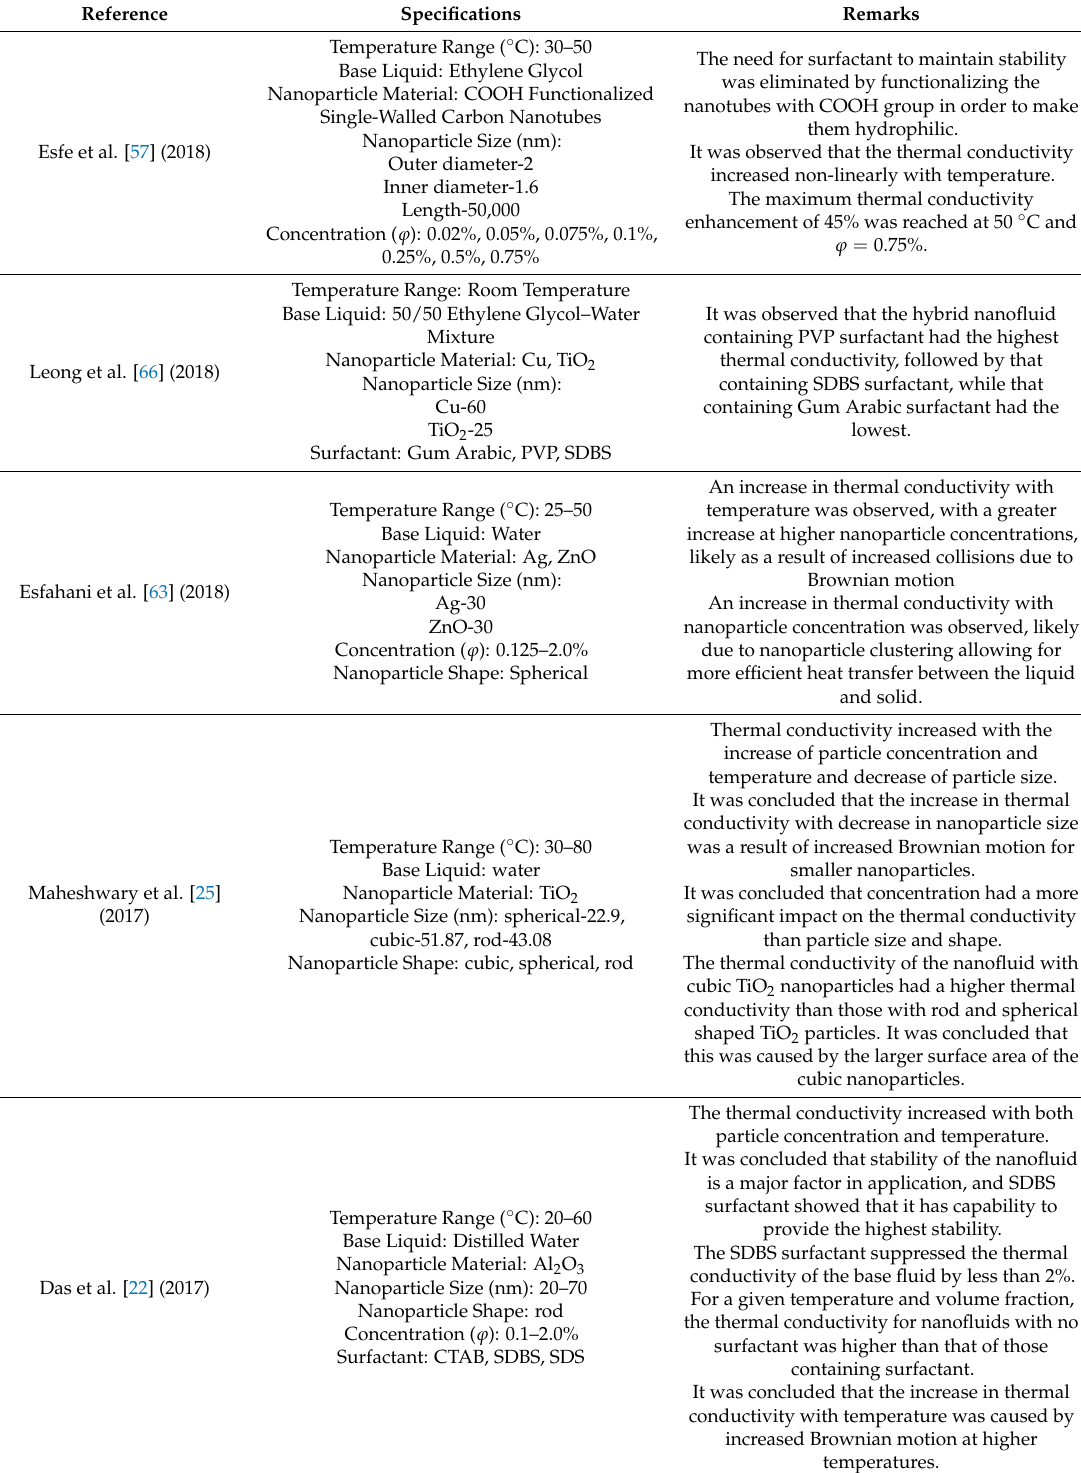
Table A1. Summary of existing experimental investigations on thermal conductivity of